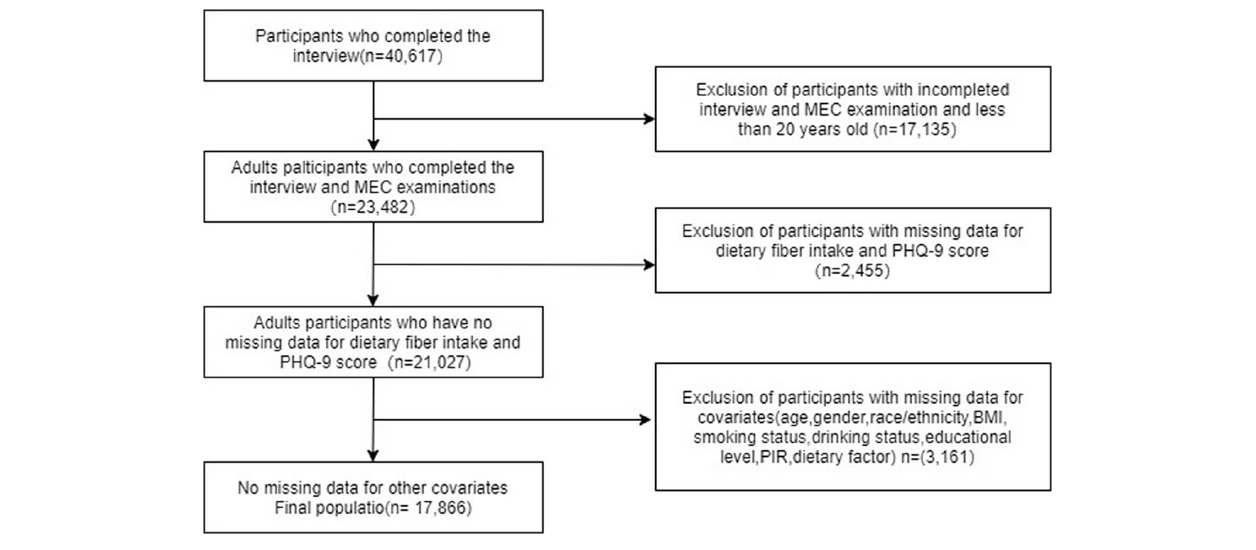
FIGURE 1 | Flowchart of participant